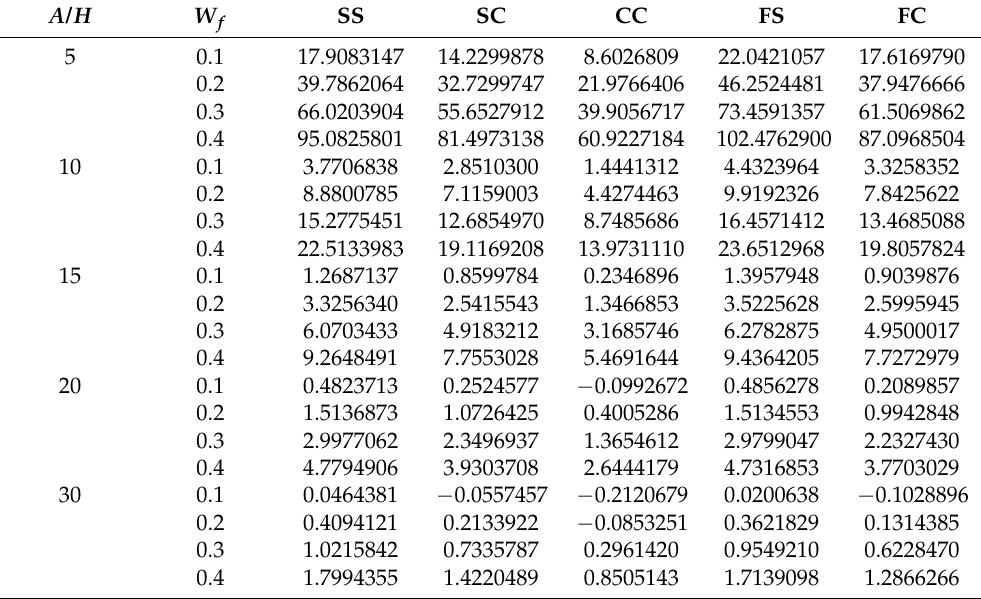
Table 5. Dimensionless normal stress σ ∗ of FG porous nanocomposite piezoelectric square plates 11 under various boundary conditions and for different values of side-to-thickness ratio A / H and GPLs weight fraction W f ( x 3 / H =